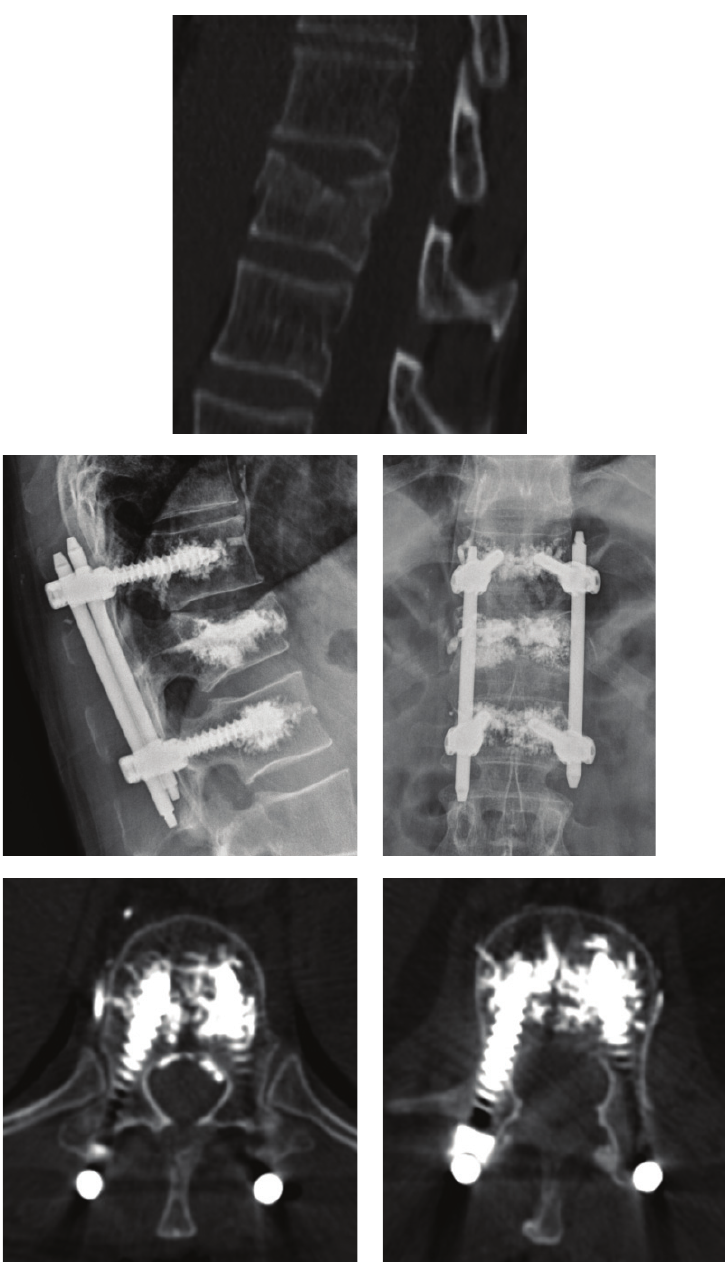
Figure 1: T12 type A3.1 fracture treated with cemented fenestrated screw and kyphoplasty.